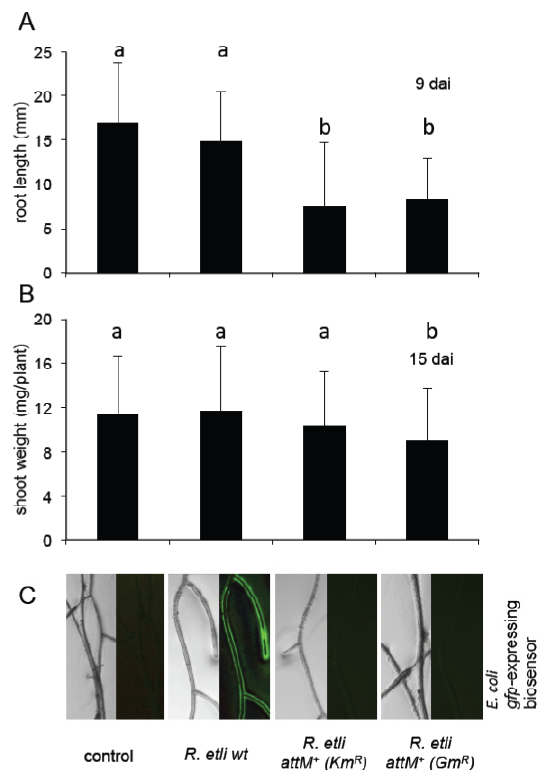
Figure 8. R. etli producing oxo-C8-HSL has only moderate impact on Arabidopsis growth. ( A ) Root length of Arabidopsis plants co-inoculated with the indicated R. etli strains for 9 days; ( B ) Fresh weight of shoots of plants inoculated with R. etli strains during 15 days; ( C ) AHL production by R. etli strains used in the above experiments on Arabidopsis roots detected by the biomarker bacteria E. coli . Letters indicate statistical differences